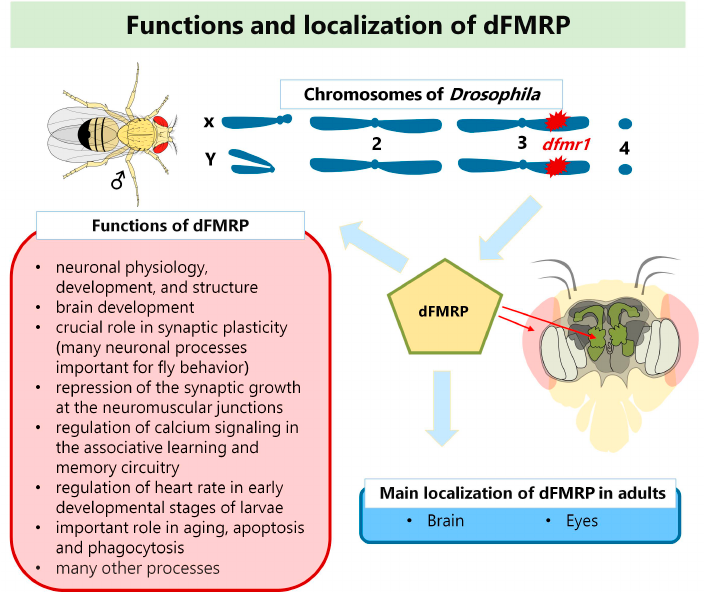
Figure 1. Functions and localization of dFMRP in D. melanogaster (adapted from reference [21]) Aberrations: dfmr1 -Fragile X Messenger Ribonucleoprotein 1 gene in Drosophila ; dFMRP- dfmr1 protein in D. melanogaster.